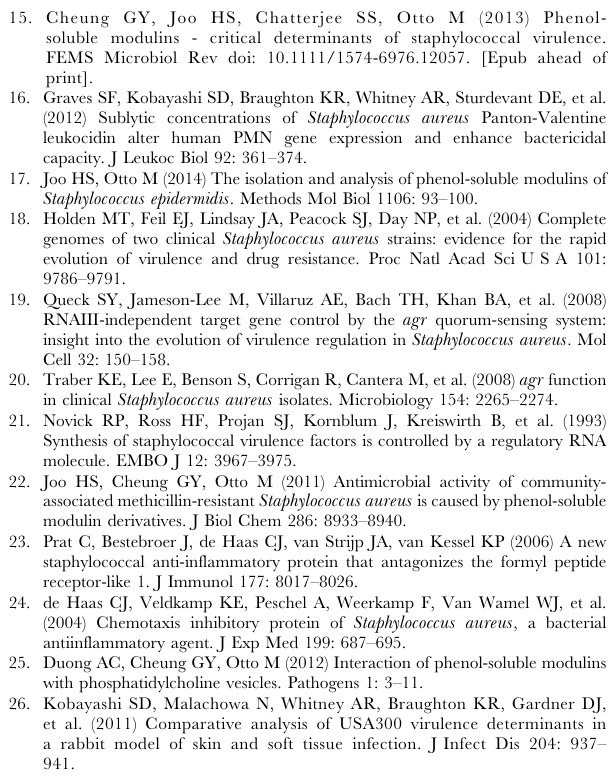
Figure S1 PSM a 3/PSM a 3N22Y production in MRSA252 and 22030 wild-type and genetically altered strains, and in PSM-free USA300 strains, in which the peptides were expressed from a plasmid. Data are from three independent cultures. Analysis was by HPLC/MS. The asterisk marks the strains in which the CC30 psm a 3 gene was altered to express non-CC30 PSM a 3. Figure S2 Mouse model of skin infection. Female Crl:SKH1- hrBR hairless mice were injected subcutaneously with , 4 6 10 7 CFU of S. aureus strains 252 or 252* (number of mice, 25 per group), or , 5 6 10 6 CFU of S. aureus strains 22030 or 22030* (number of mice, 15 per group) in 50 m l of PBS in the left flank of the mouse. The length (L) and width (W) of the abscess or lesion caused by the bacterial infection was measured with an electronic caliper daily for 14 d post infection and calculated using the formula L 6 W. Typically, strain MRSA 252 caused closed abscesses and strain 22030 open lesions.